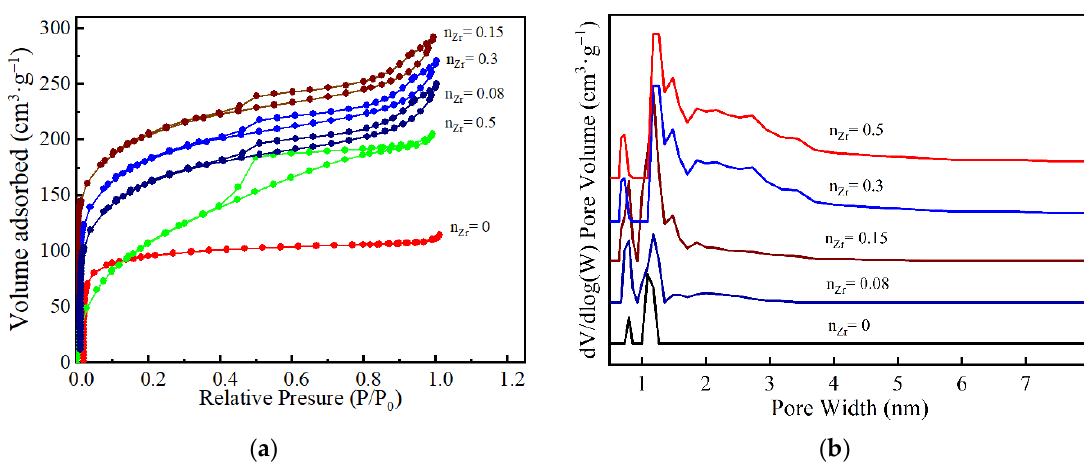
Figure 8. ( a ) The nitrogen adsorption-desorption isotherms and ( b ) the corresponding pore size distribution curves for the ZrO 2 -MSiO 2 materials with various n Zr . Table 1. Pore structure parameters of the ZrO 2 -MSiO 2 materials with various n Zr .